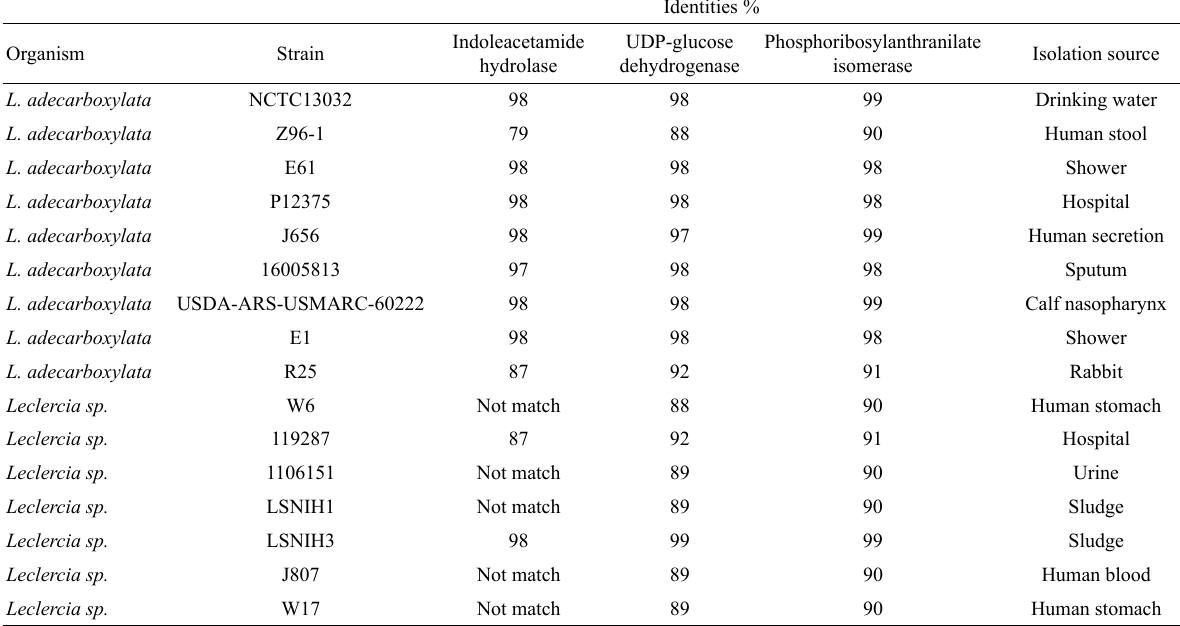
Table 3 – Plant growth promotion genes in all strains compared.